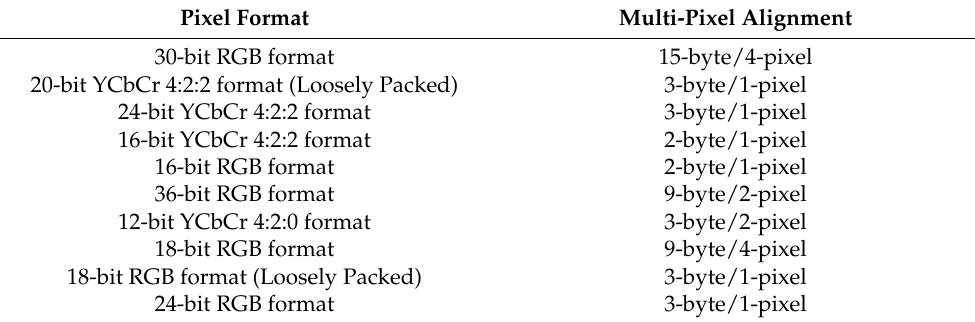
Table 1. MIPI DSI standard pixel formats [4].